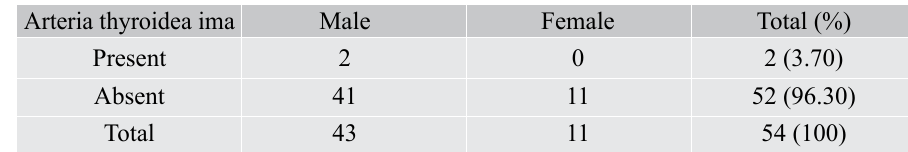
Table I: Observation of arteria thyroidea